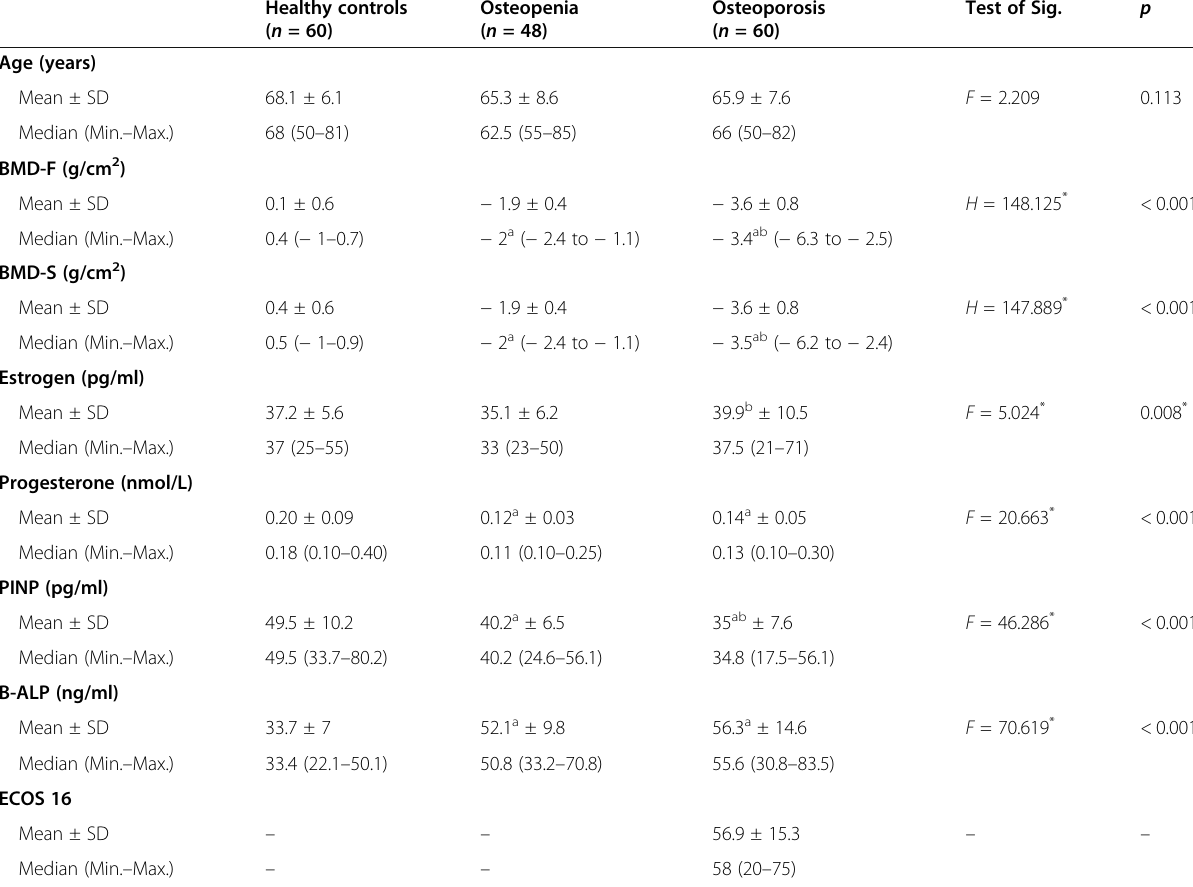
Table 1 Comparison between the three studied groups according to different parameters Healthy controls ( n = 60)